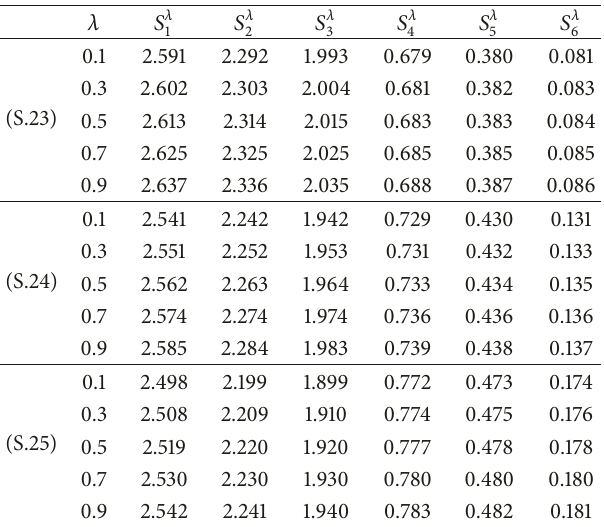
Table 4: Continued. Table 5: Critical values to evaluate fuzzy 𝑥